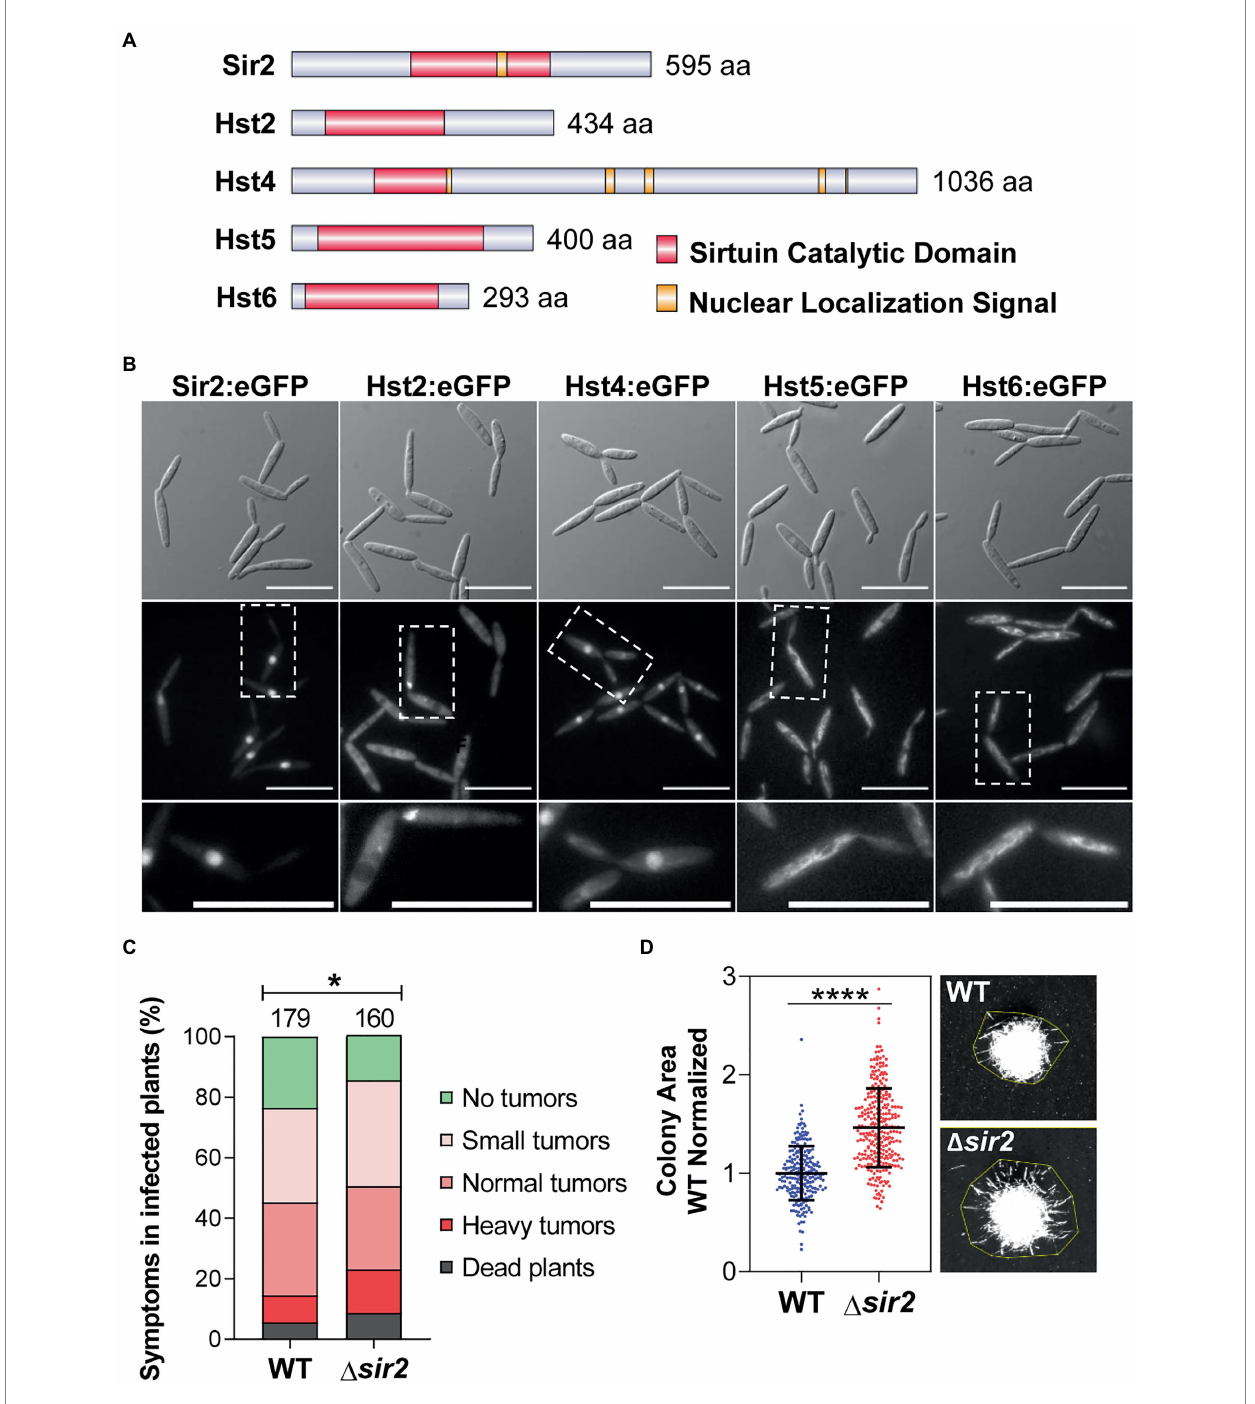
FIGURE 1 The nuclear sirtuin Sir2 is involved in the virulence and filamentation of Ustilago maydis . (A) Schematic representation of all the sirtuins identified in U. maydis . (B) Subcellular localization of the indicated U. maydis sirtuins tagged with eGFP in its endogenous loci . Scale bar represents 20 μ m. (C) Quantification of symptoms for plants infected with the wild-type and Δ sir2 mutant at 14 dpi. Total number of infected plants is indicated above each column. Three biological replicates were analyzed. Mann–Whitney statistical test was performed (* p -value < 0.05). (D) Quantification of the area of the wild-type and Δ sir2 mutant single colonies grown on PD–charcoal plates for 48 h at 25 ° C. The colony area was measured as indicated in the stereoscopic images. Data was normalized with the mean of the area of the wild-type colonies. Three biological replicates were analyzed. Student’s t -test statistical analysis was performed (**** p -value <